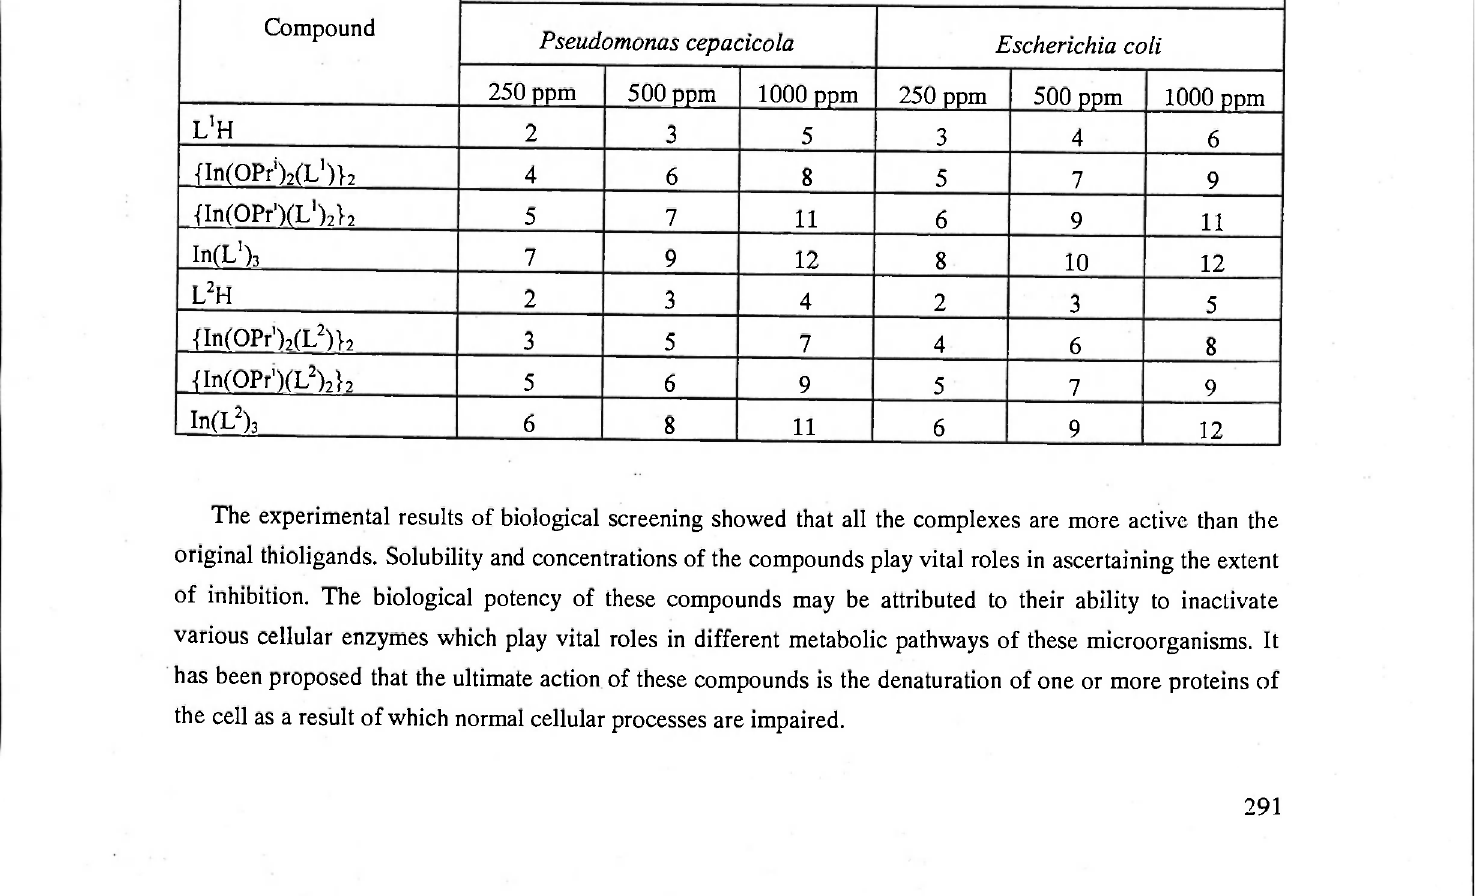
Bactericidal Screening Data of L'H, L 2 H and their Metal Complexes